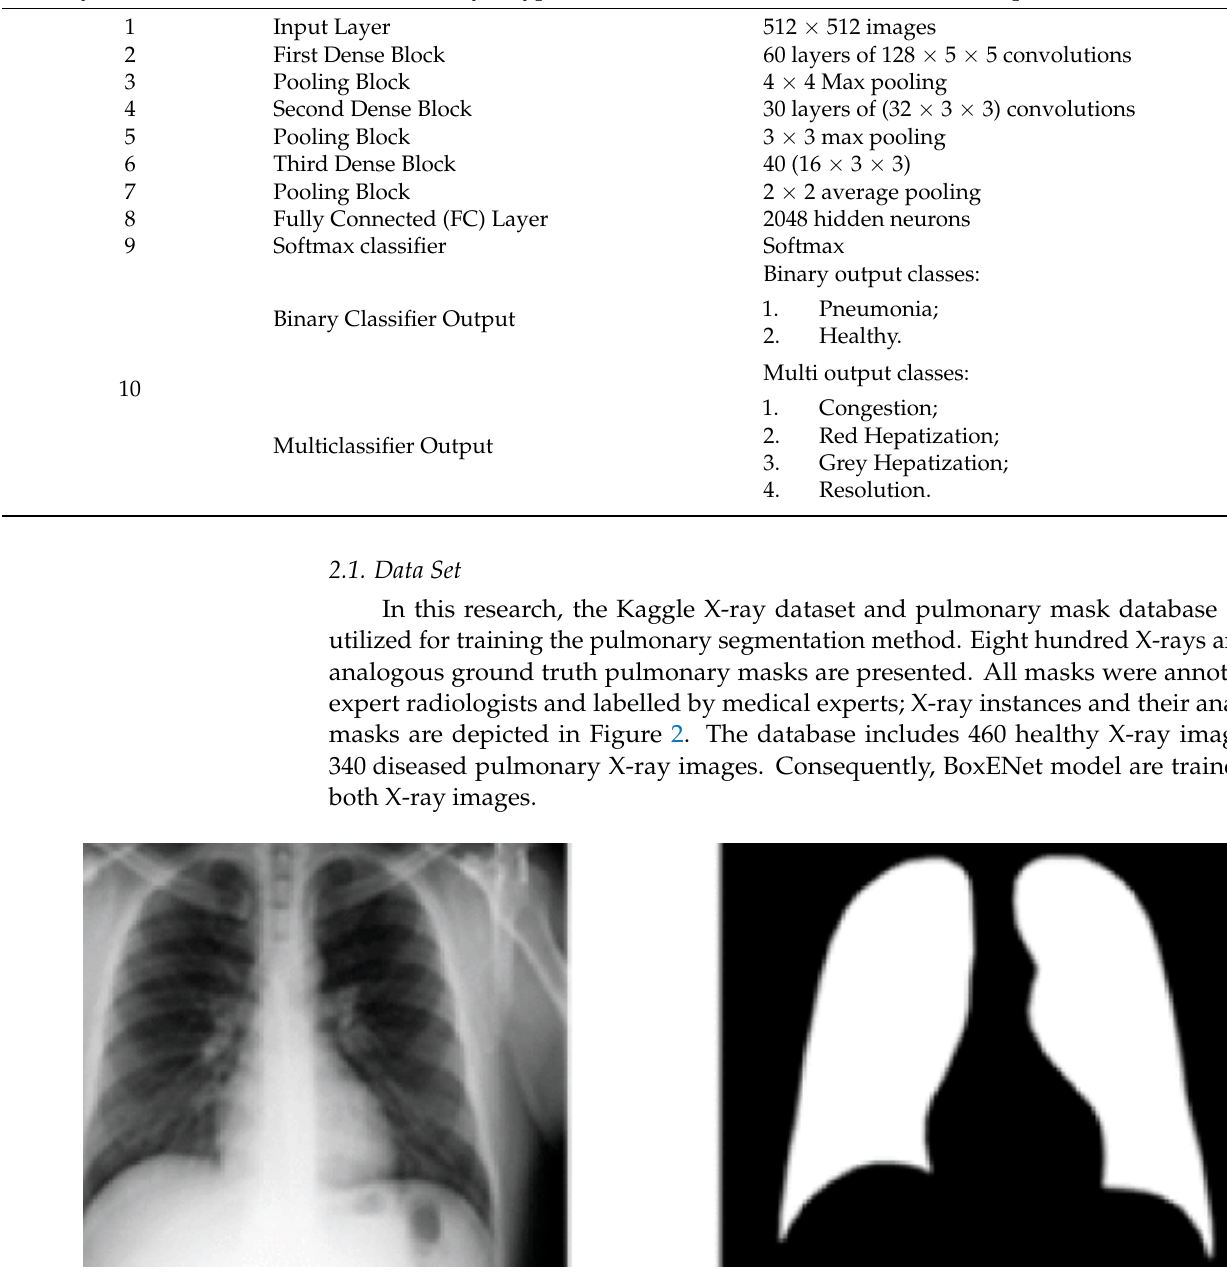
Table 2. The architecture of the BoxENet and its parameters.